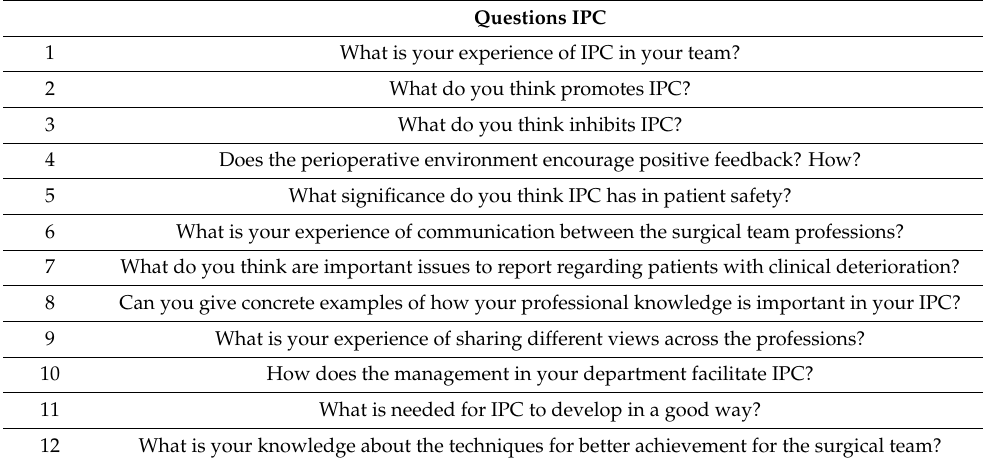
Table 1. Questions participants’ interview guide